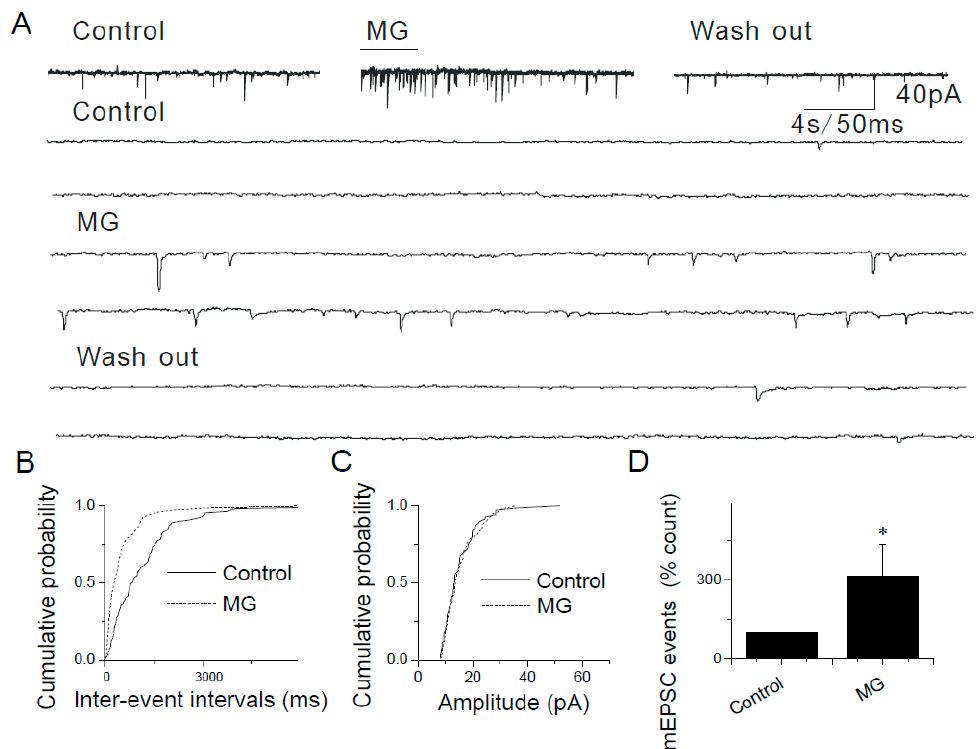
Figure 4. Modulation of synaptic transmission in the NTS by methylglyoxal (MG). ( A ) Application of MG (50 µ M) increases the frequency of mEPSCs in a reversible manner. The synaptic events are shown in higher time resolution below. ( B ) Cumulative probability plot showing decreased interevent intervals representing increased frequency of mEPSCs ( p < 0.0001, KS test). ( C ) The increase in frequency is not accompanied by a change in the amplitude. ( D ) Summary graphs showing that MG-mediated increase in mEPSCs ( n = 7, * p < 0.05). The asterisk (*) represents p < 0.05 as compared to control.